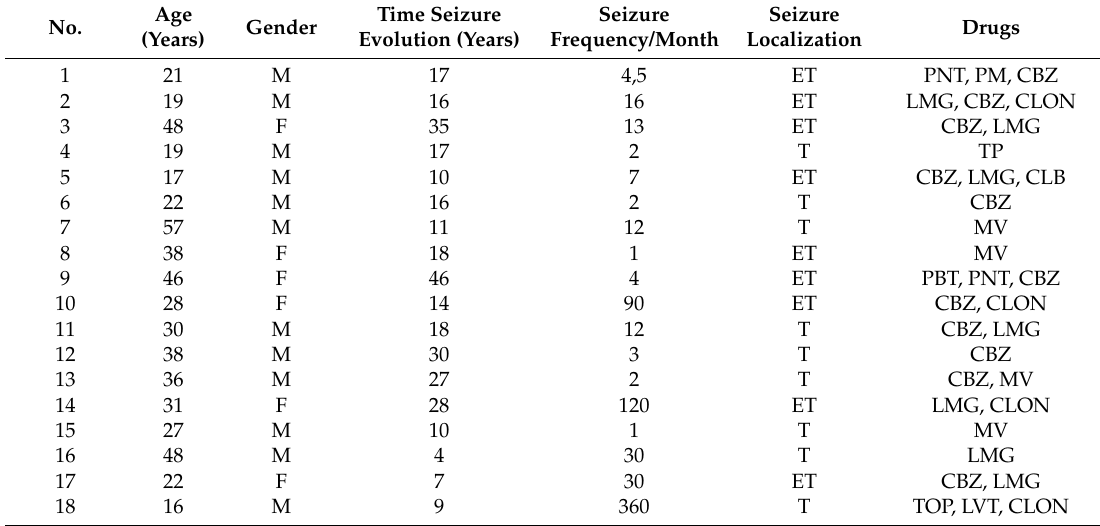
Table 1. Clinical data of patients with drug resistant complex partial